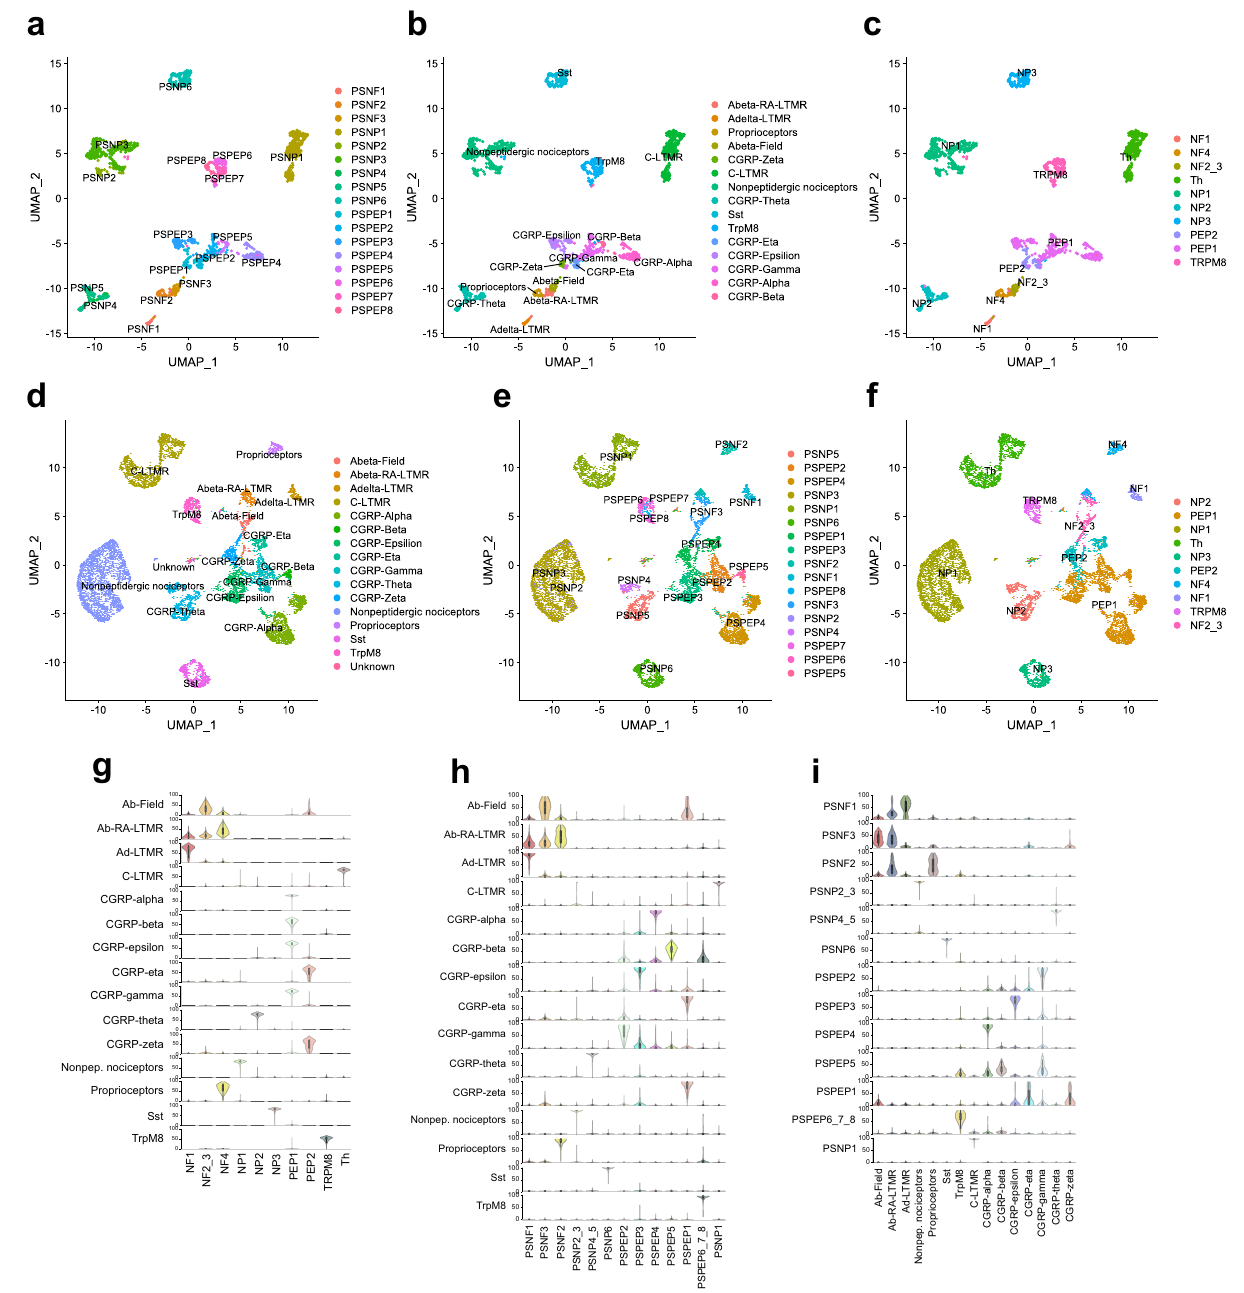
Fig. 2 Consensus of mouse DRG neuron types across datasets and nomenclatures. a – f UMAPs showing a Zeisel types with Zeisel nomenclature, b Zeisel data after label transfer from Sharma data, c Zeisel data with Usoskin nomenclature, d Sharma data with original nomenclature, e Sharma data after label transfer from Zeisel data, and f Sharma data with Usoskin nomenclature. g Probability scores of Sharma types against Zeisel trained module (performed with Usoskin nomenclature). h Probability scores of Sharma types against Zeisel trained module (performed with Zeisel nomenclature). i Probability scores of Zeisel types against Sharma trained module (performed with original nomenclature from Sharma). Boxplots in g – i de fi ne the median, interquartile range (IQR), and 1.5 × IQR